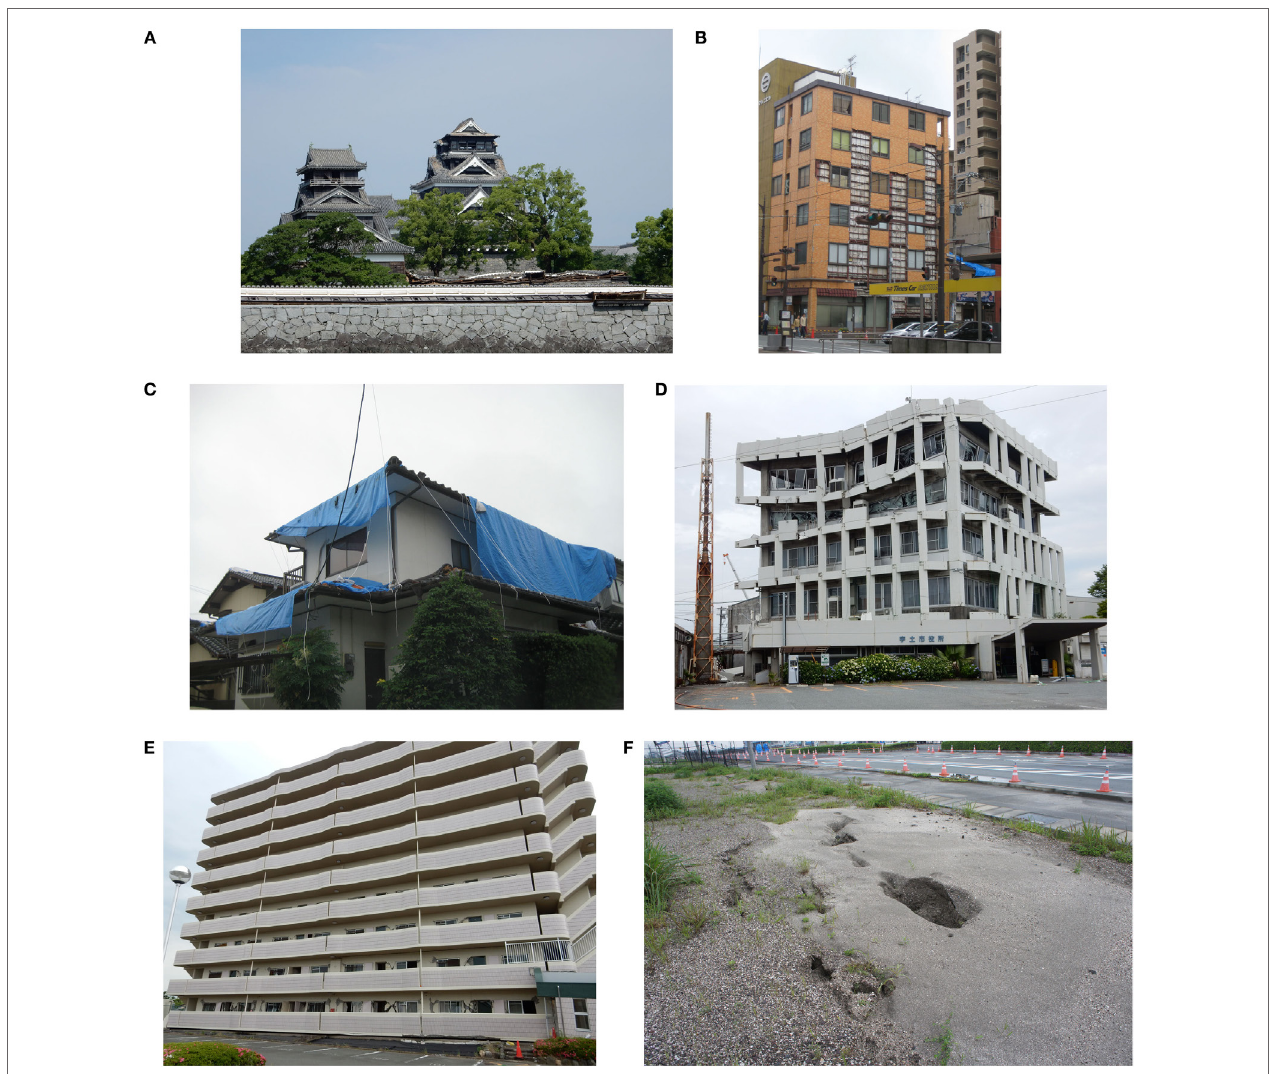
FigUre 12 | (a) Damage to Kumamoto castle (location 1 in region 1). (B) Cladding damage to a building in the city center (location 1 in region 1). (c) Roof damage near KMM006. (D) Damage to the Uto city office (location 2 in region 1; near KMM008). (e) Damage to a high-rise residential building (location 3 in region 1). (F) Liquefaction site at Kumamoto port (location 4 in region